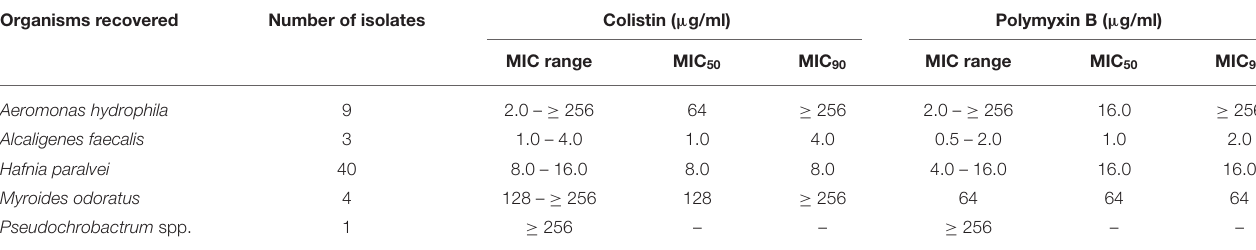
TABLE 2 | Colistin and polymyxin B MICs of colistin-resistant organisms recovered from Victorian poultry farms. Organisms recovered